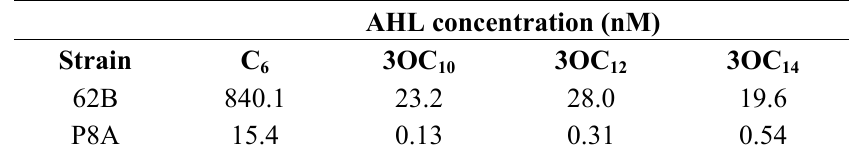
Table A3. AHL concentration (nM) detected by LC-MS/MS for strains 62B and